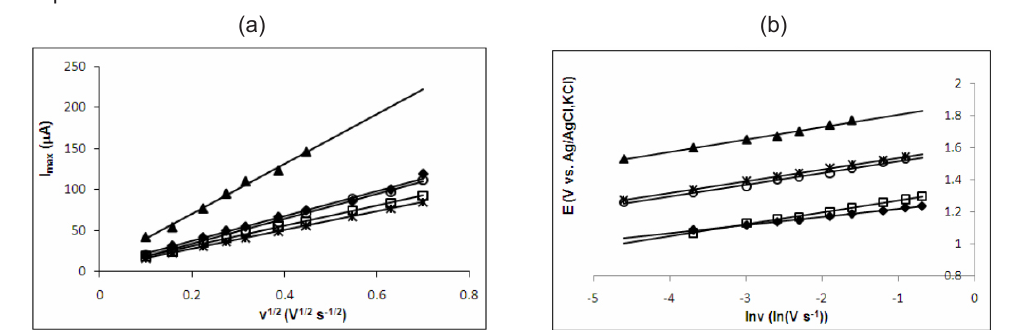
Figure 1. Linear variation of: (a) current peak intensity with the square root of the scan rate; (b) peak potential with the logarithm of the potential scan rate for 10 -3 M aminophylline ( ◆ ) theophylline ( ◆ ), caffeine ( ▲ ), codeine phosphate ( ○ ) and papaverine hydrochloride ( ) solutions in acetate buffer at pH 4.5 (Working electrode electrochemically activated glassy carbon; reference electrode Ag/AgCl, (3 M KCl); auxiliary electrode Pt wire; 20 o C).